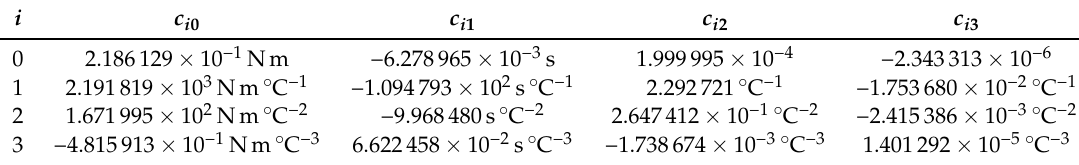
Table 2. Fitting coefficients c ij of Equation (3) for different coefficients C i